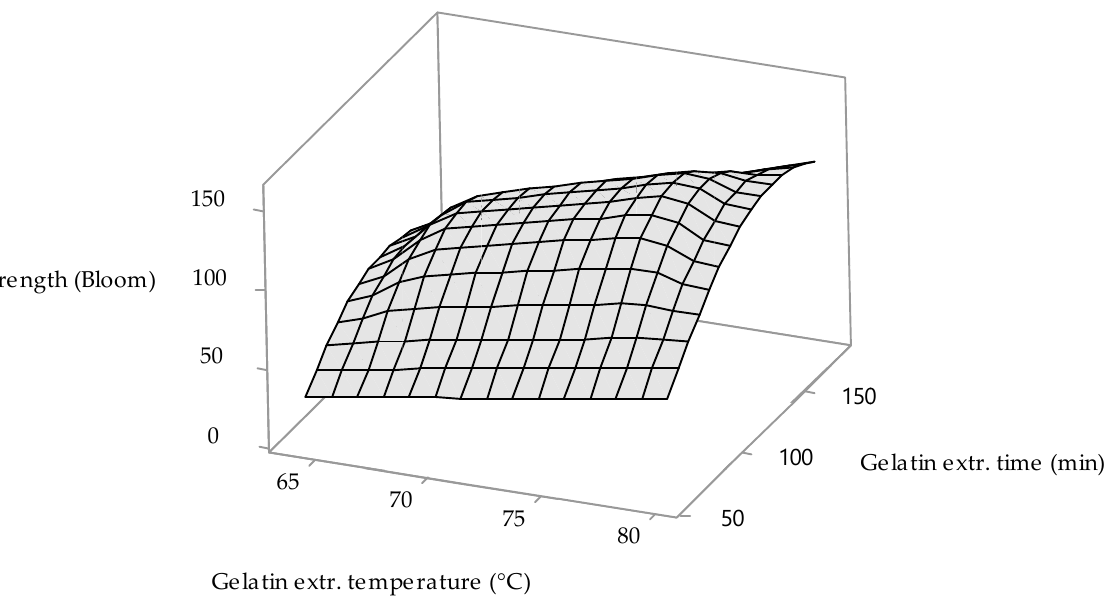
Figure 2. The influence of the gelatin extraction temperature and gelatin extraction time on the gelatin gel strength.